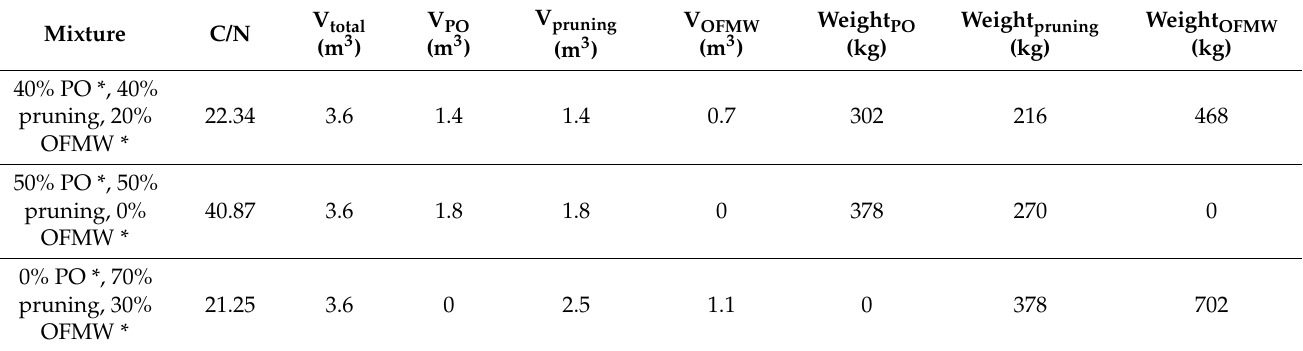
Table 2. Mixtures chosen for the experimental test for each